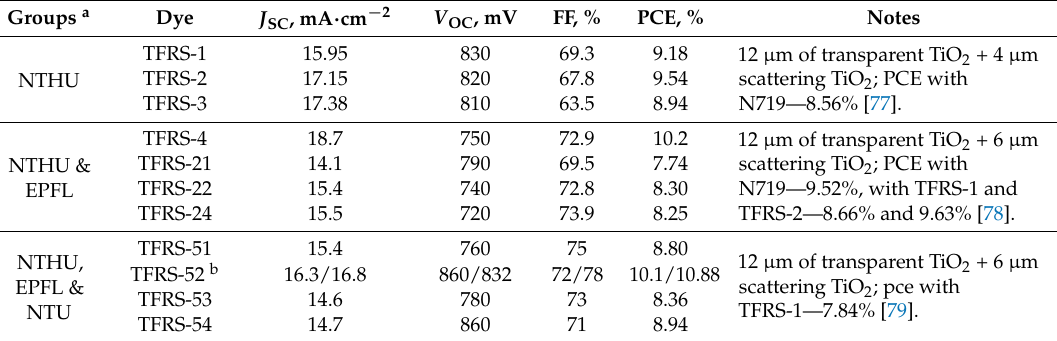
Table 3. Photovoltaic performance of selected TFRS series sensitizers with bidentate ligands. Groups a